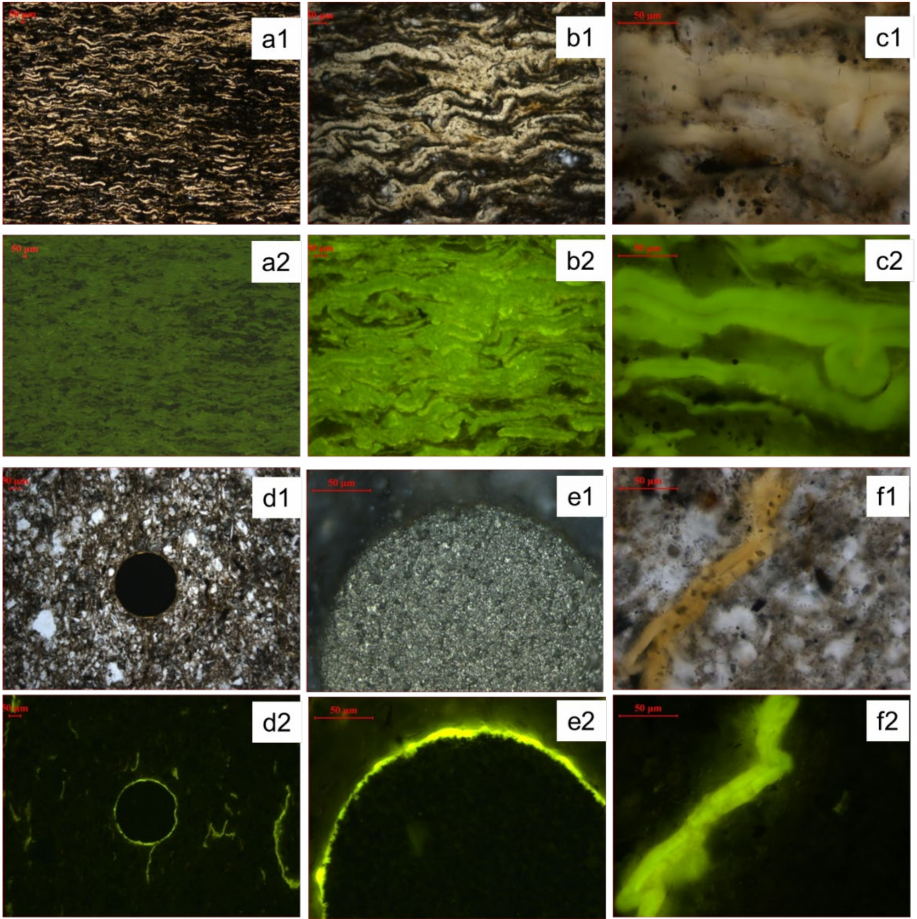
Figure 2. Photomicrographs of Tasmanites in oil shale samples ( a – c ) and mudstone samples ( d – f ). ( a1 – f1 ) were taken under transmitted light, while ( a2 – f2 ) were taken under reflected fluorescence light. Panel e1 is the photo under reflected white light. Scale bar = 50 µ